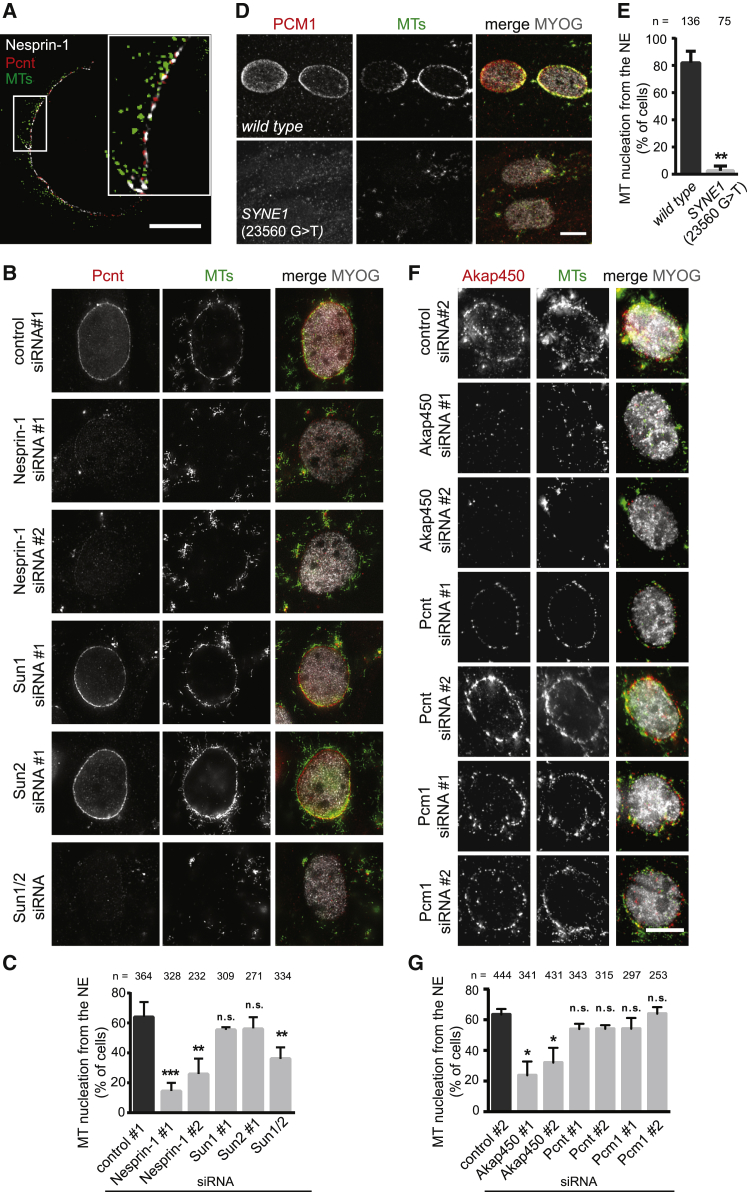
MT Nucleation from the NE Requires Nesprin-1, Sun1/2, and Akap450(A) 3D-SIM fluorescent image of the nucleus of a differentiated C2C12 cell, stained for Nesprin-1 (white, MANNES1E), Pericentrin (Pcnt, red), and microtubules (MTs, green) after 5 min nocodazole washout to allow MT regrowth. The scale bar represents 5 μm.(B) 48 hr differentiated C2C12 cells, treated with the indicated siRNAs, were immunostained for Pericentrin (Pcnt, red), microtubules (MTs, green) and Myogenin (MYOG, gray) after nocodazole washout. The scale bar represents 10 μm. See also Figure S3A.(C) Quantification of the mean percentage (%) of Myogenin-positive cells with MT nucleation from the NE as described in (B). Error bars ± SD; n represents total number of nuclei from at least three independent experiments. ∗∗∗p < 0.001; ∗∗p < 0.01; n.s., not statistically significant, t test.(D) Differentiated human immortalized myotubes from a healthy control (wild-type) or from a patient carrying a nonsense mutation within the SYNE1 gene (23560 G>T) were immunostained for PCM1 (red), microtubules (MTs, green) and Myogenin (MYOG, gray) after nocodazole washout. Images represent maximum projections of confocal z sections. The scale bar represents 10 μm. See also Figures S3B and S3C.(E) Quantification of the mean percentage (%) of Myogenin-positive cells with MT nucleation from the NE as described in (D). Error bars ± SD; n represents total number of nuclei from two independent experiments. ∗∗p < 0.01; t test.(F) 48 hr differentiated C2C12 cells, treated with the indicated siRNAs were immunostained for Akap450 (red), microtubules (MTs, green) and Myogenin (MYOG, gray) after nocodazole washout. The scale bar represents 10 μm.(G) Graph shows the mean percentage (%) of Myogenin-positive cells with MT nucleation from the NE as described in (F). Error bars ± SEM; n represents total number of nuclei from two independent experiments. ∗p < 0.05; n.s., not statistically significant, one-way ANOVA with Dunnett’s multiple comparisons test.